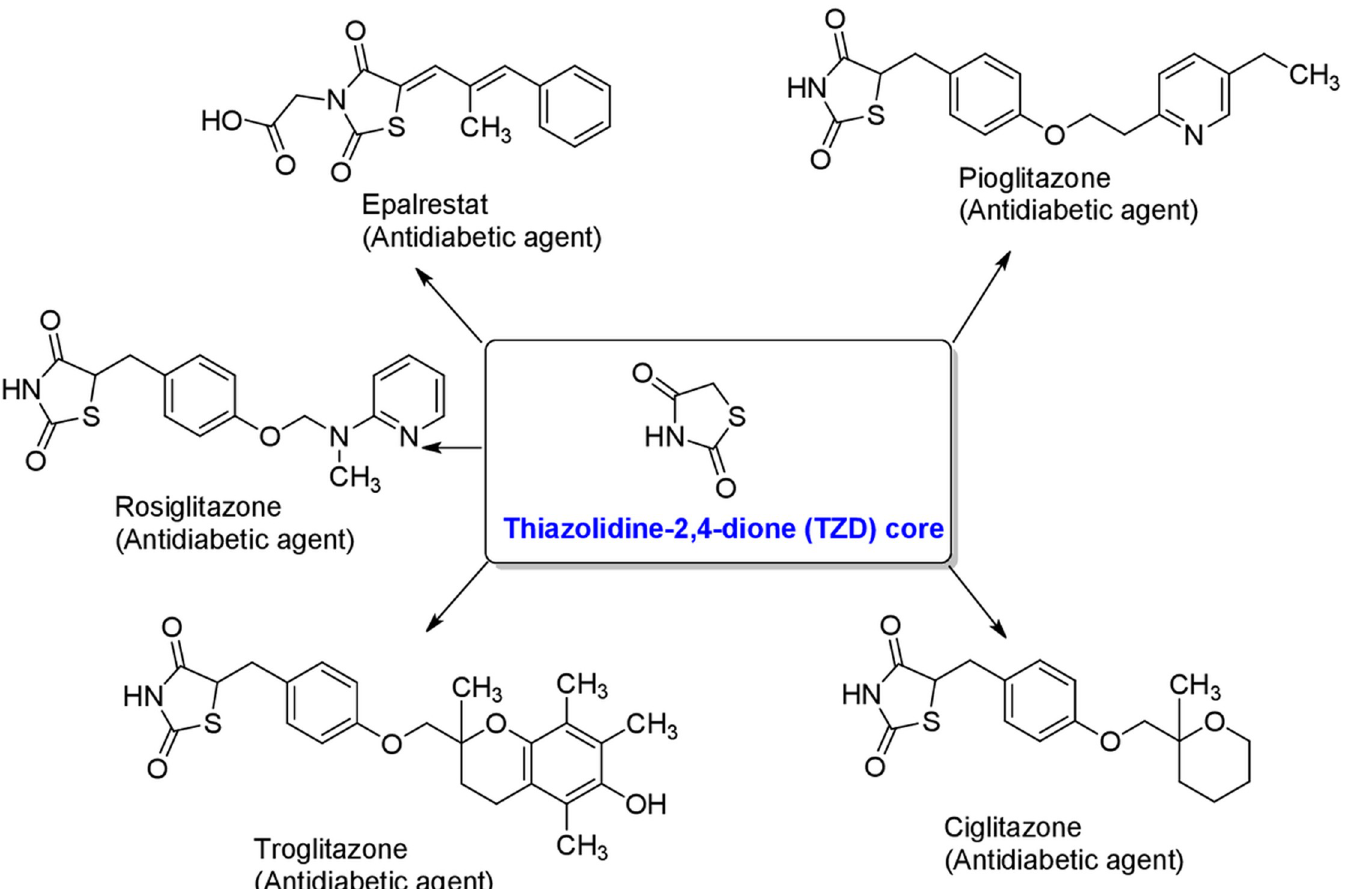
Fig 1. Thiazolidine-2,4-dione (TZD) and its derivatives.